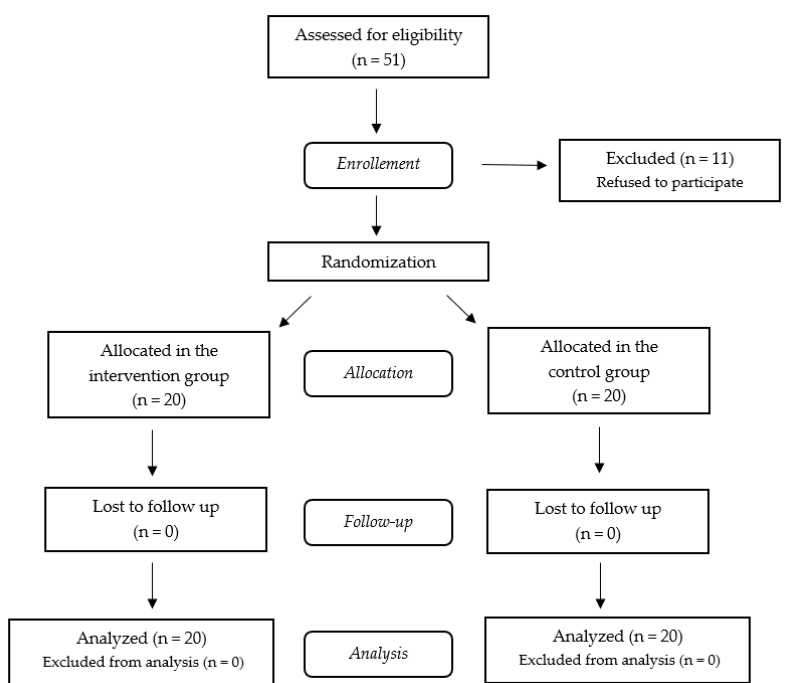
Figure 1. CONSORT flow chart of the study.